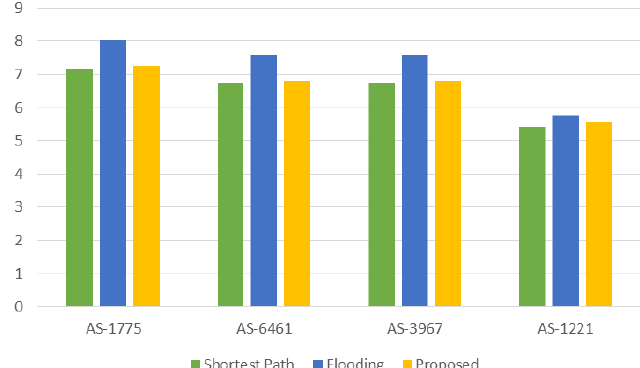
Figure 9. Comparison in average hop count. The proposed scheme can achieve the near optimal packet delivery in all four